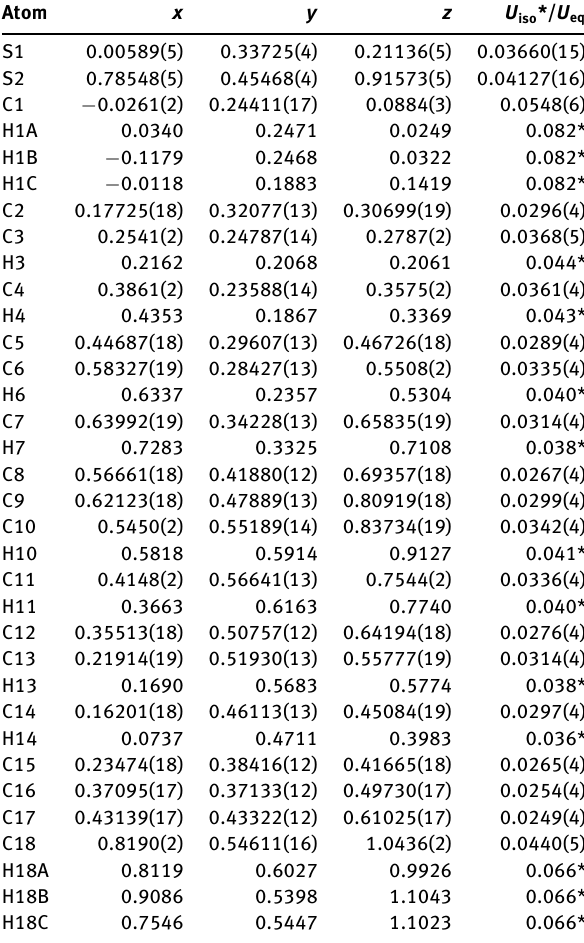
Table 2: Fractional atomic coordinates and isotropic or equivalent isotropic displacement parameters (Å 2